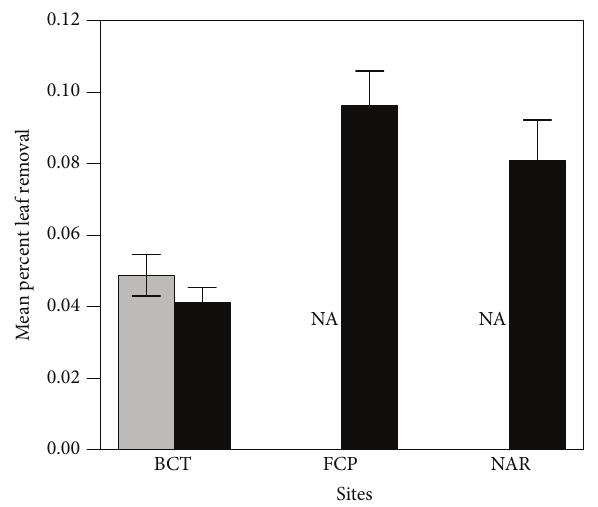
Figure 2: Herbivory (percent leaf loss) on A. petiolata varied between sites and habitats in 2013. Gray bar represents data from 2011; black bars represent data from 2013.